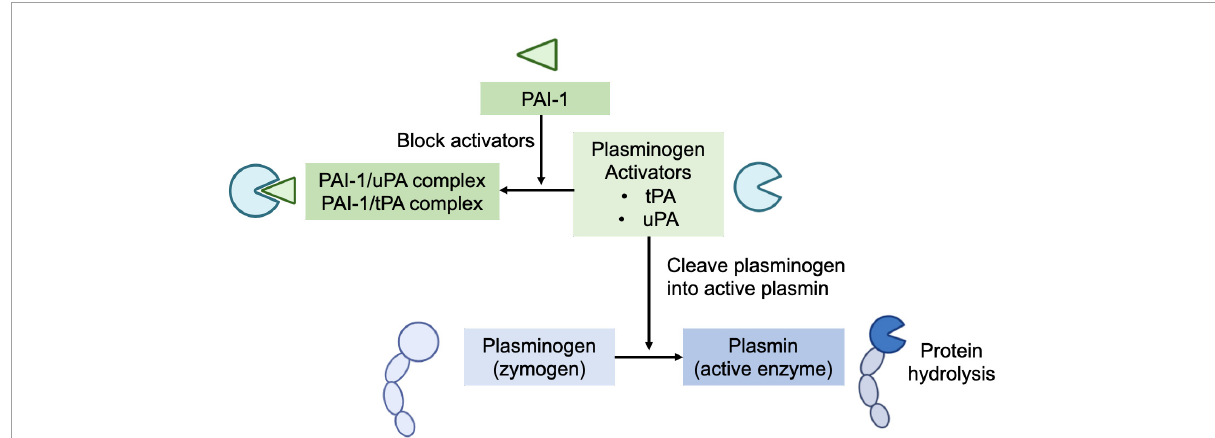
FIGURE1 Human milk’s plasmin system is composed of plasminogen (zymogen), plasmin (the active enzyme), urokinase-type plasminogen activator (uPA), and tissue-type plasminogen activator (tPA) (plasminogen activators), and human plasminogen activator inhibitor type 1 (PAI-1) (plasminogen activator inhibitor). Plasminogen (the inactive zymogen) must be cleaved by uPA or tPA to become the active plasmin. The PAI-1 in human milk can block the activators’ (both tPA and uPA) conversion of plasminogen to active plasmin.